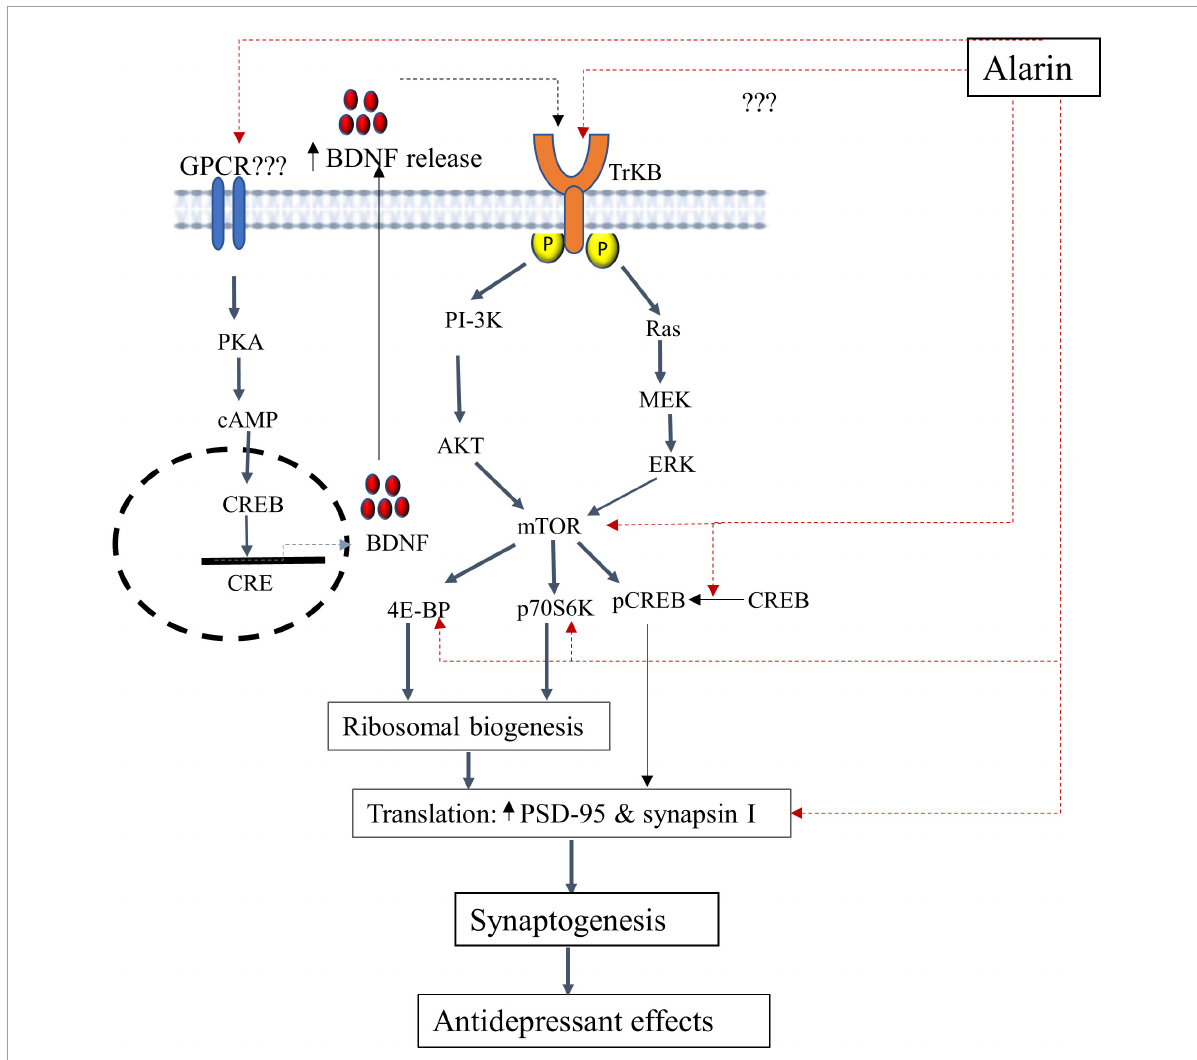
FIGURE1 A schematic illustration of the putative antidepressant mechanism of alarin targeting the TrkB-mTOR signaling pathway and BDNF secretion. In this pathway, alarin may exert antidepressant-like effects by interacting with TrkB, possibly as a ligand, and stimulating downward signaling components like ERK and AKT. Besides, alarin may affect the activity of CREB by enhancing its phosphorylation. It also exhibits antidepressant effects by increasing mTOR, 4E-BP, p70S6K, PSD-95, and synapsin I. Moreover, alarin enhances the secretion of natural antidepressant peptide (BDNF) through a pathway that is not yet well defined. The synthesis and release of BDNF from the transcription process activates TrkB receptors and the downstream mTOR signaling pathway, which coincides with the therapeutic response. BDNF-or alarin-activated mTOR triggers the translational machinery, increasing synaptic protein (PSD-95 and synapsin I) synthesis involved in synaptogenesis to confer an antidepressant effect. BDNF, brain-derived neurotrophic factor; CREB, cAMP response element-binding protein; CRE, cAMP response element; ERK, extracellular signal-regulated kinase; mTOR, mammalian target of rapamycin; PI3K, phosphatidylinositol 3-kinase; p70S6K, ribosomal protein S6 kinase; PKA, protein kinase A; PSD-95, post-synaptic density 95; 4E-BP1, eukaryotic initiation factor 4E-binding protein 1; TrkB, tropomyosin-related kinase